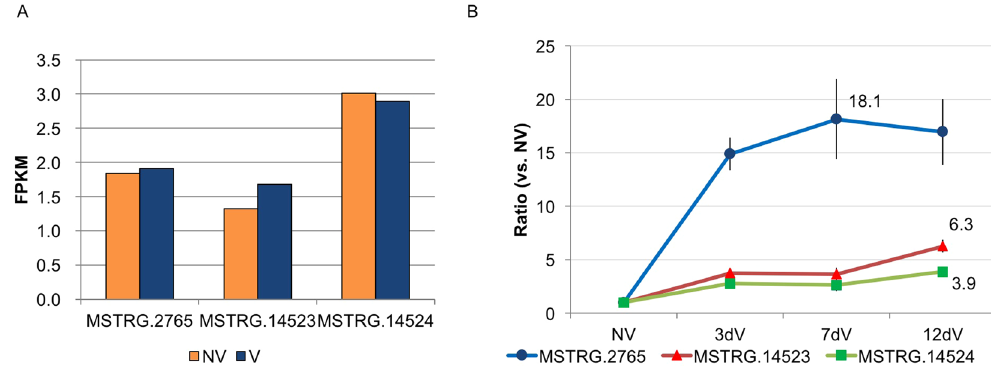
Figure 7. Expression levels of three NATs before and after cold treatment. ( A ) RNA-seq expression (FPKM) for three NATs before (NV) and after (V) four weeks of cold treatment. Differential expression analysis showed that none of the three NATs were differentially expressed at the FDR < 0.05 level. ( B ) qPCR results showing expression ratios normalized to NV for three NATs prior to cold treatment (NV), three, seven, and twelve days into cold treatments (3dV, 7dV, and 12dV, respectively). BrFLC2as (MSTRG.2765), MAF1 homolog Bra024350as (MSTRG.14523), MAF4 homolog Bra024351as